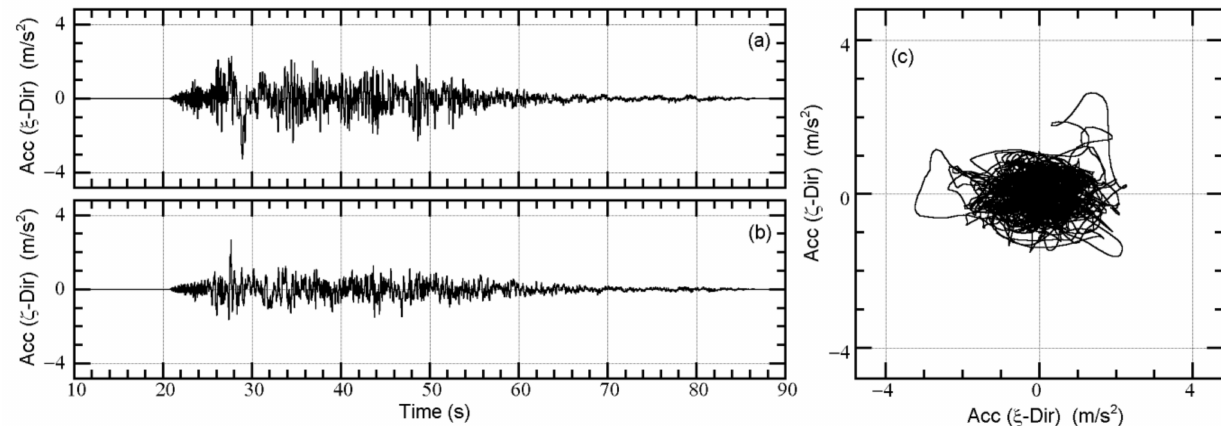
Figure A3. Two components of the recorded ground motion (TCU): ( a ) ξ direction; ( b ) ζ direction; ( c ) orbit.